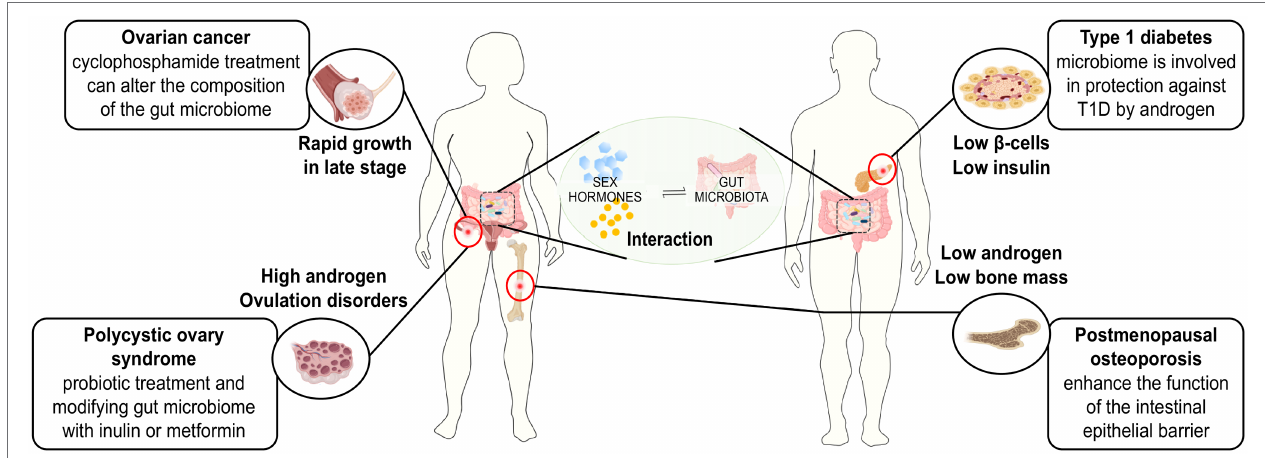
FIGURE 2 | Treating strategies for sex hormone-related diseases based on the interaction between sex hormones and gut